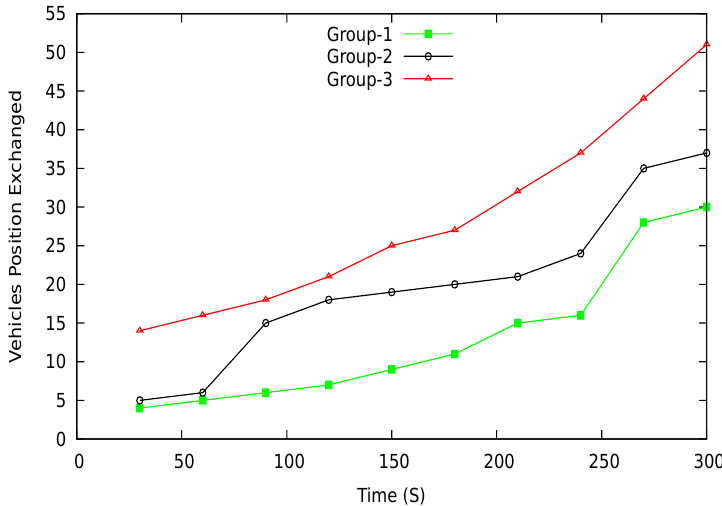
Figure 22. Vehicle position exchanged at different groups.